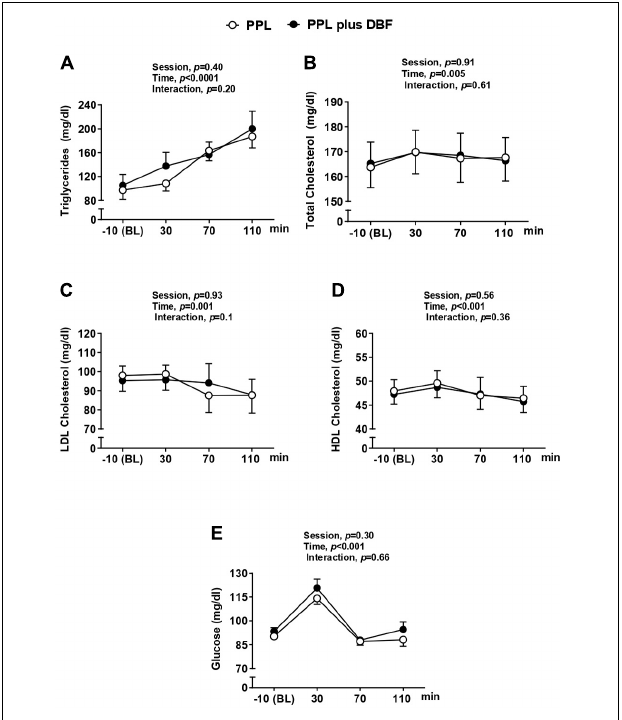
FIGURE 2 | Triglycerides (A) , glucose (B) , total cholesterol (C) , and HDL cholesterol (D) to postprandial lipemia (PPL) and PPL plus disturbed blood flow (DBF) in healthy individuals. HDL cholesterol, high density lipoprotein cholesterol. Data presented as mean ± standard